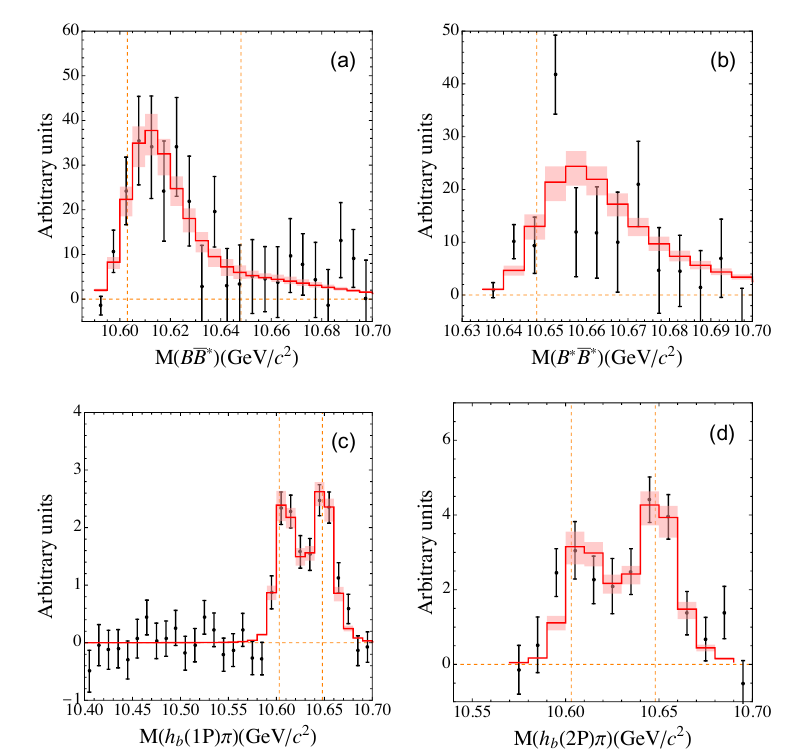
Figure 1. The fitted line shapes for the most advanced pionful fit of Ref. [9] with the uncertainties corresponding to a 1 σ deviation in the parameters of the fits. The experimental data are from Refs. [1, 4].